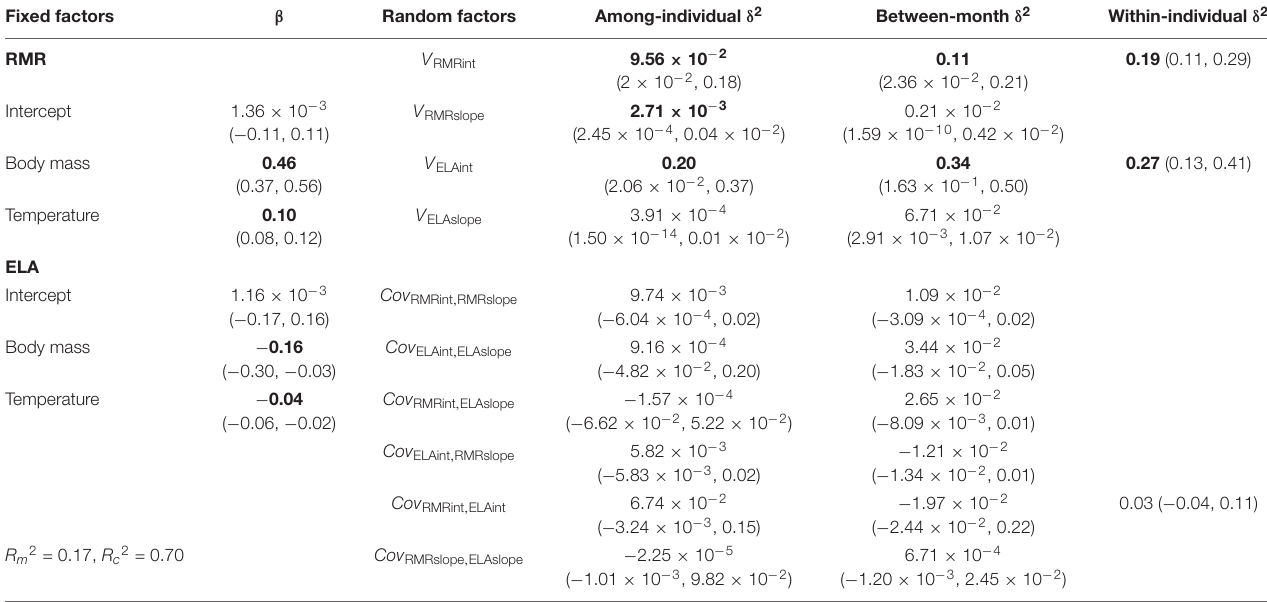
TABLE 3 | Parameters [estimates with 95% credibility intervals (CI)] for multivariate mixed models examining co(variation) among intercepts and slopes of reaction norms for resting metabolic rate (RMR) and exploratory locomotor activity (ELA) in juvenile Alpine newts ( Ichthyosaura alpestris